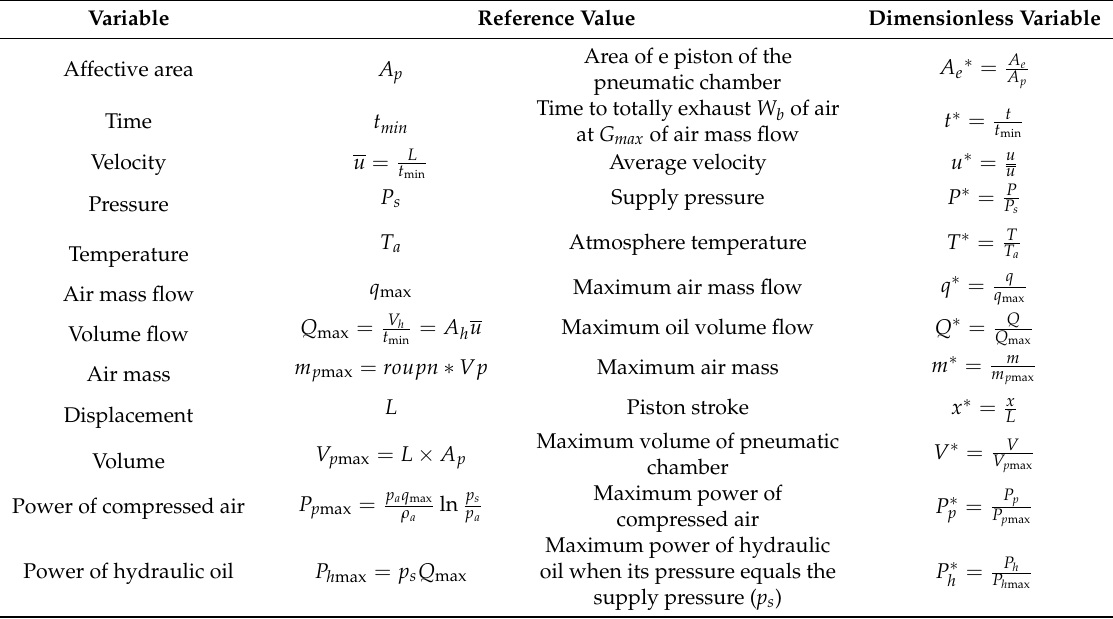
Table 1. Reference values and dimensionless